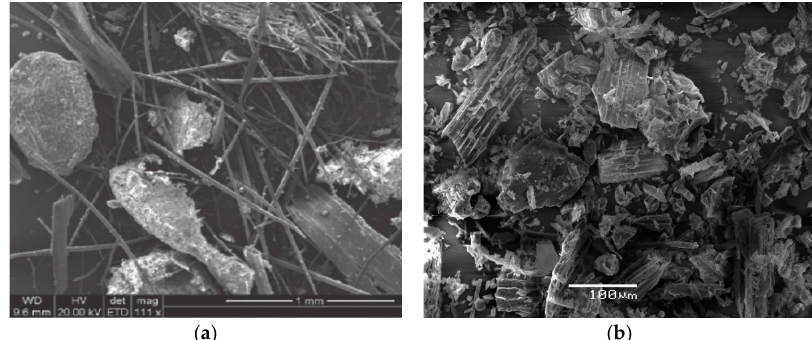
Figure 4. SEM micrograph: ( a ) Oat hulls and ( b ) BO.